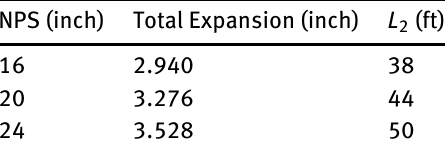
Table 4: Required loop length.